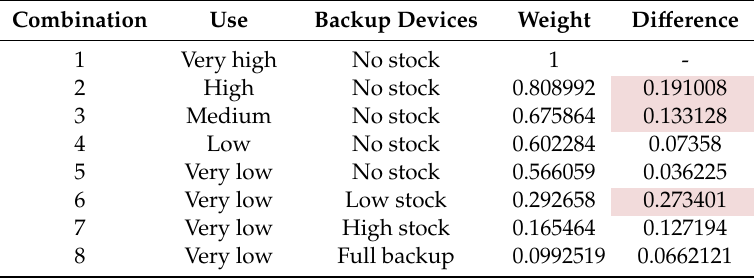
Table 20. Top–down technique for the criterion Impact of operation.